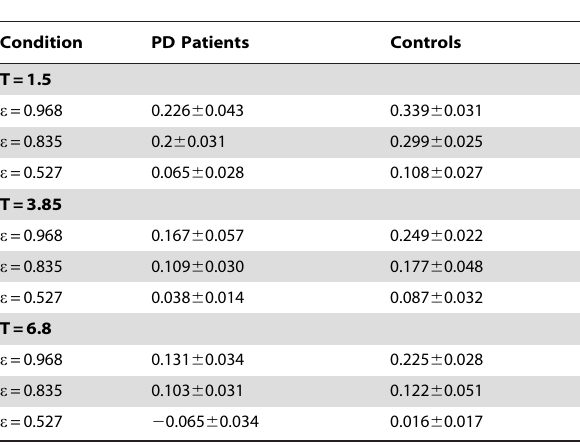
Table 3. Mean b f choices along with the corresponding STEs across all the experimental